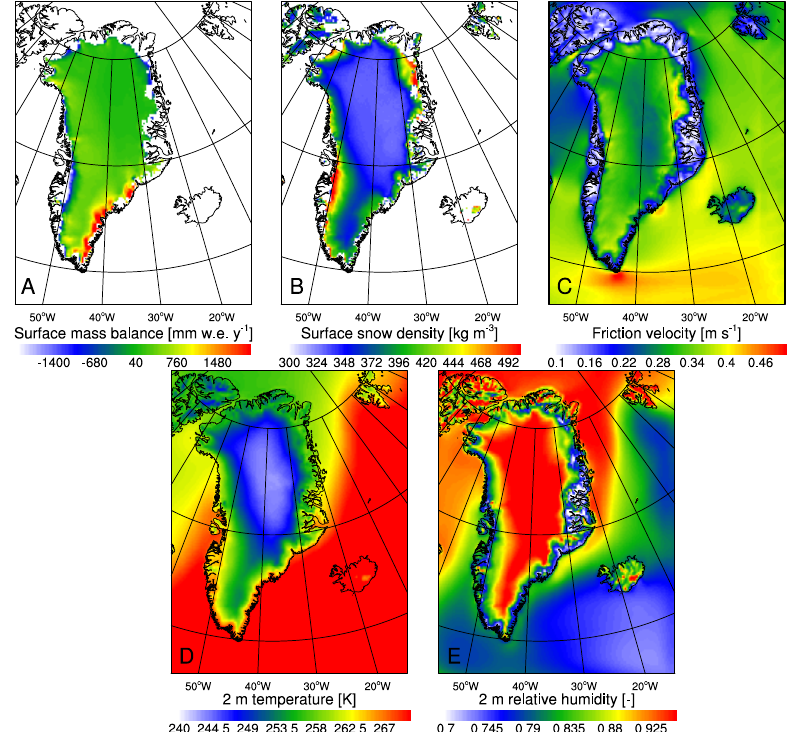
Fig. 4. Mean (1960–2011) modeled (A) surface mass balance (mm w . e . yr − 1 ), (B) surface snow density (kg m − 3 ), (C) friction velocity (m s − 1 ), (D) 2m temperature (K) and (E) 2m relative humidity w.r.t. ice (–). slopes in rough topography that are not fully resolved by the